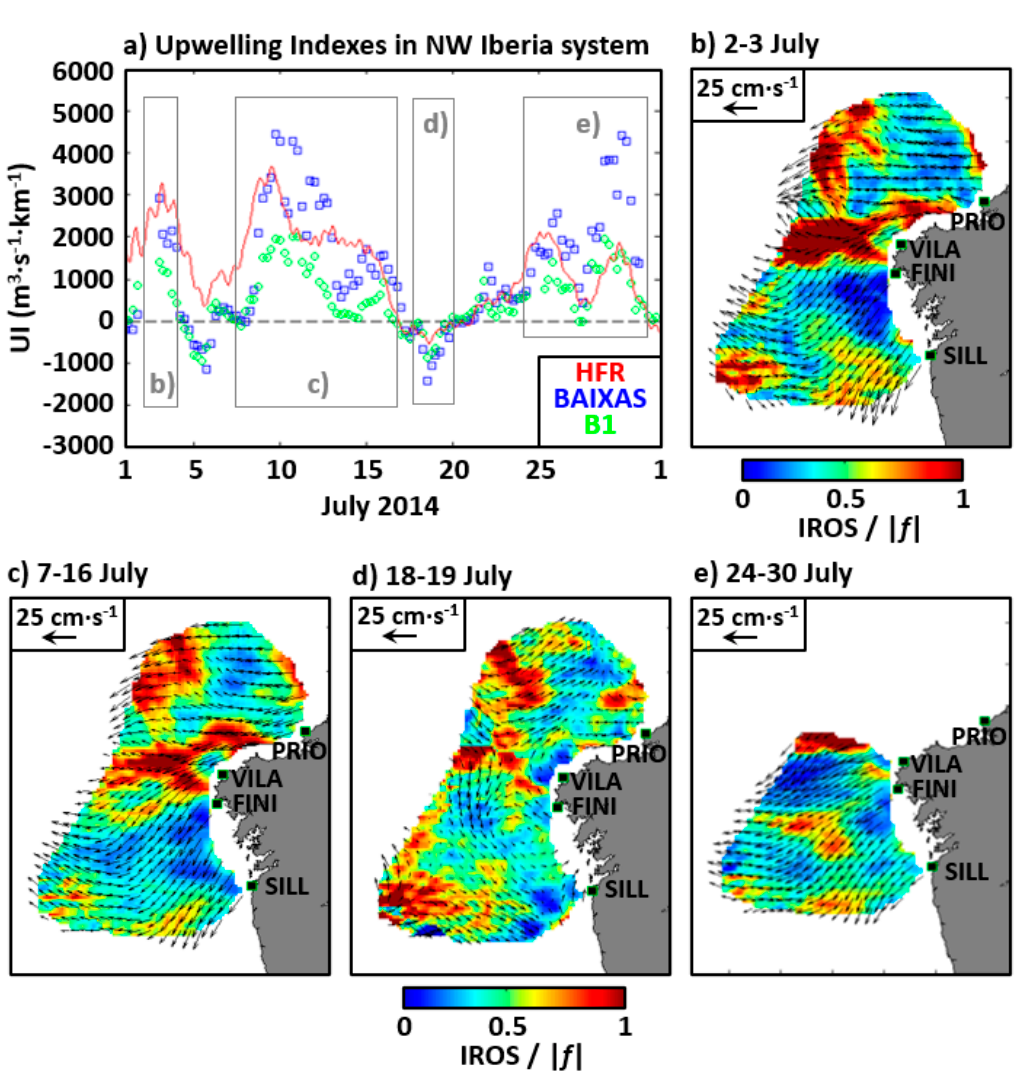
Figure 12. ( a ) Temporal evolution of hourly UI HFR (red line) and 6-hourly UI BAIXAS (blue squares) and UI B1 (green dots) during July 2014. Gray boxes indicate four selected UPW and DOW episodes; ( b – e ) Maps of time-averaged circulation and Instantaneous Rate of Separation (IROS) for each specific event. IROS magnitudes are normalized by the absolute value of the Coriolis parameter f .